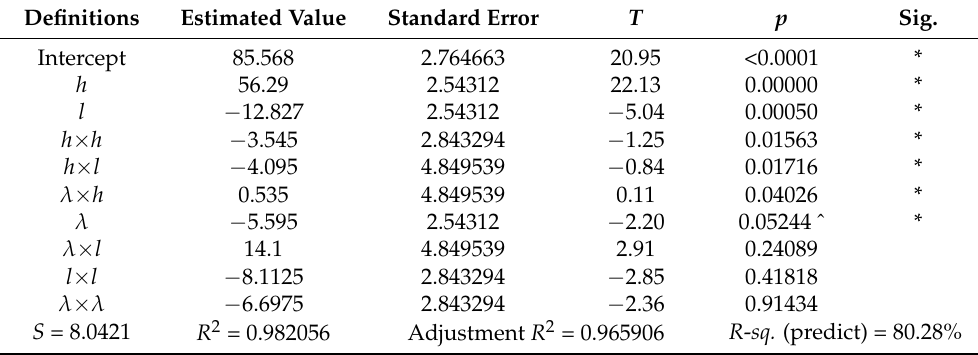
Table 7. Parameter estimates and ANOVA table for the model.